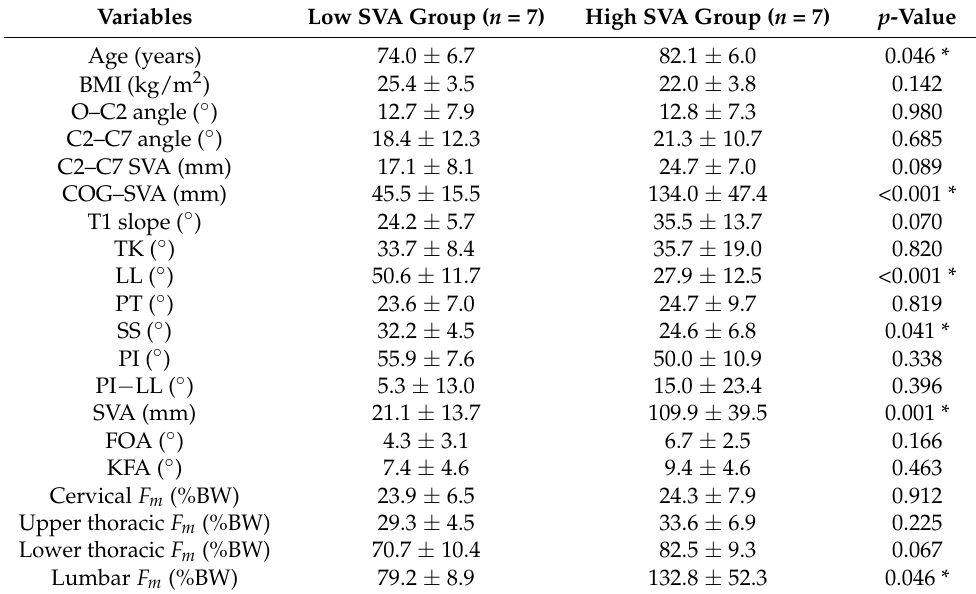
Table 2. Comparison of the low SVA and high SVA groups.